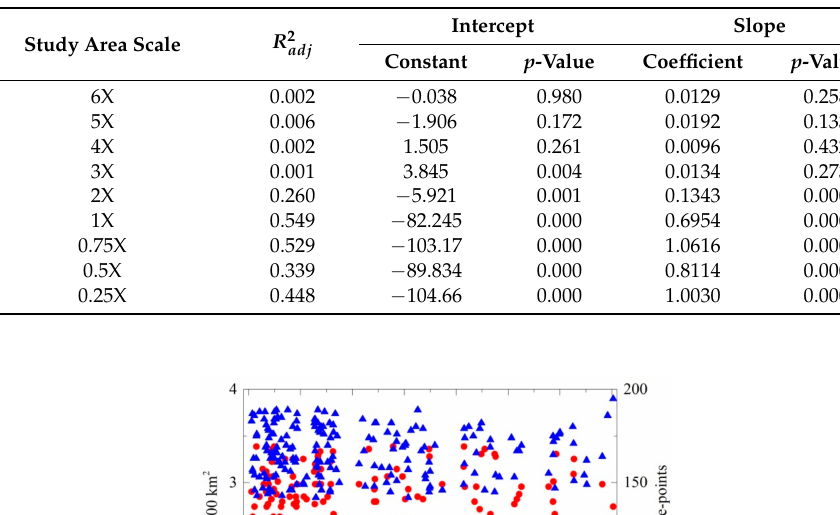
Figure 11. Relations between FR S for the whole 2100 × 2100 grid simulated landscape and FR S minus the FC MA estimate for each of the 201 TSLF maps at the relevant study area scale. Of the nine scales at which these examples were conducted, two are depicted here: 3X and 0.5X. Table 3. Linear regression results between the FR S for the whole 2100 × 2100 grid simulated landscape and FR S minus the FC MA for each of the 201 TSLF maps using the relevant study area scale.